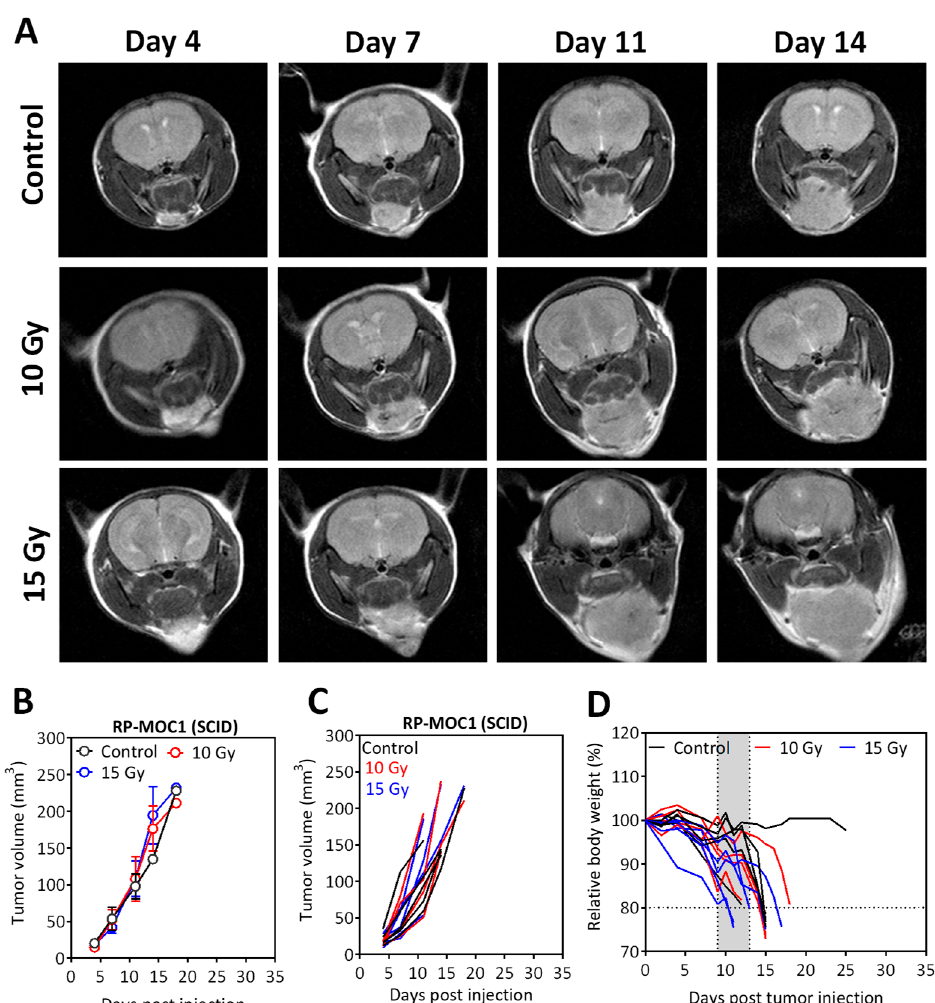
Figure 5. Radiation response of orthotopic RP-MOC1 tumors in SCID mice. ( A ) Panel of images represent axial T2-weighted images of SCID mice bearing orthotopic RP-MOC1 tumors over a 2-week monitoring period. Individual ( B ) and grouped ( C ) tumor growth curves based on MR-based tumor volume measurements obtained for animals in the control and radiation groups are shown. ( D ) Body weight measurements of animals in all three groups.